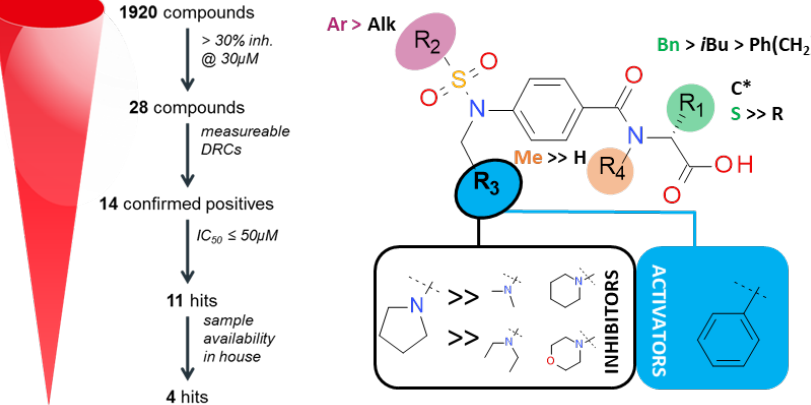
Figure 11. HTS campaign and SAR around a series of newly discovered ERAP2 modulators.